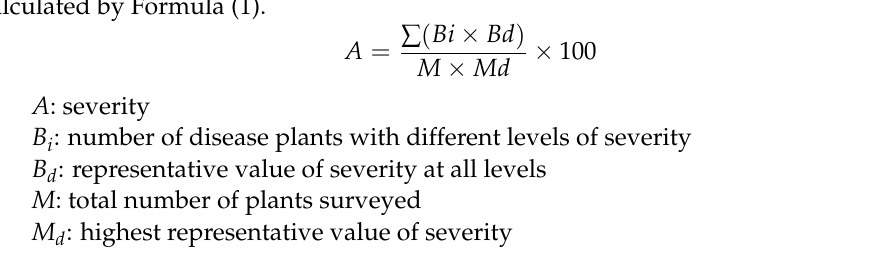
Table 5. Classification criteria for severity of rice sheath